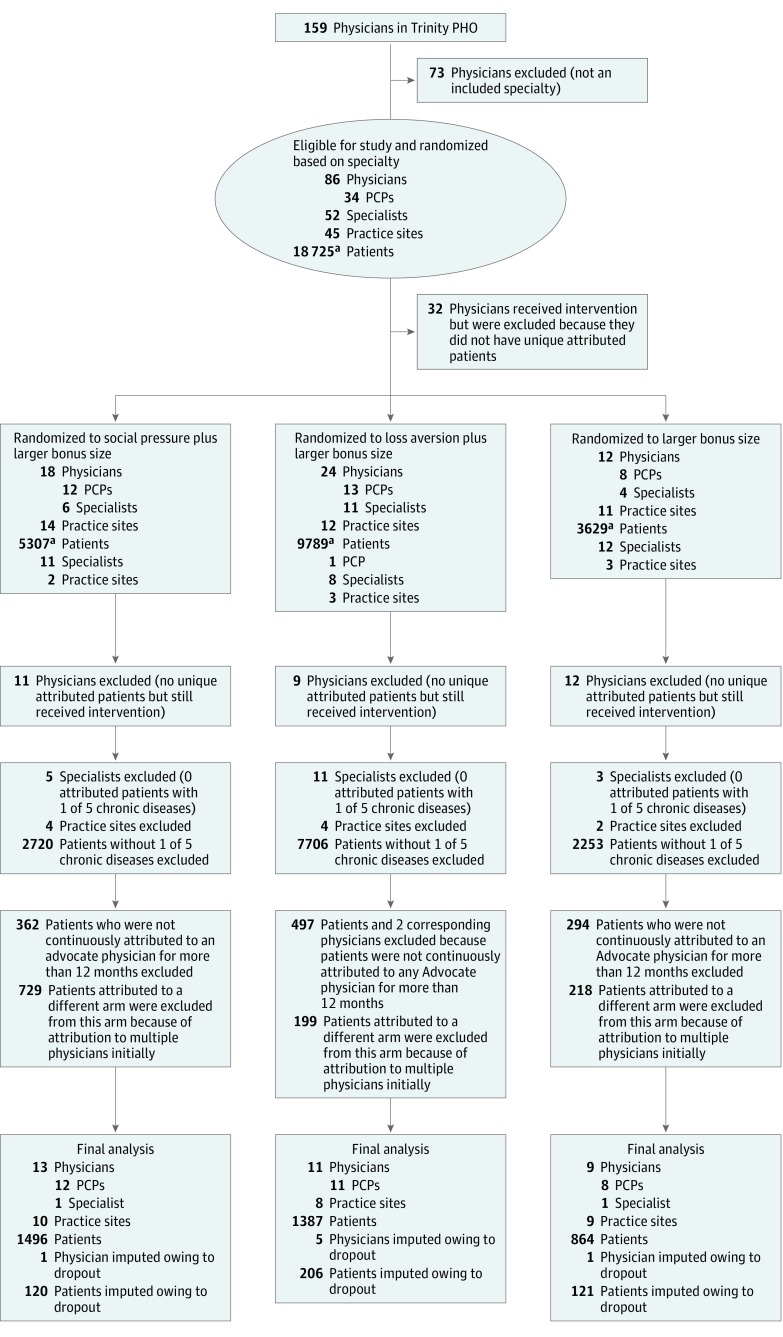
Flow Diagram of Physician, Patient, and Site Progress Through the TrialLBS indicates larger bonus size; PCP, primary care physician; and PHO, physician-hospital organization.aPatients were not uniquely attributed to 1 physician at this stage. The total number of unique patients was 16 815.